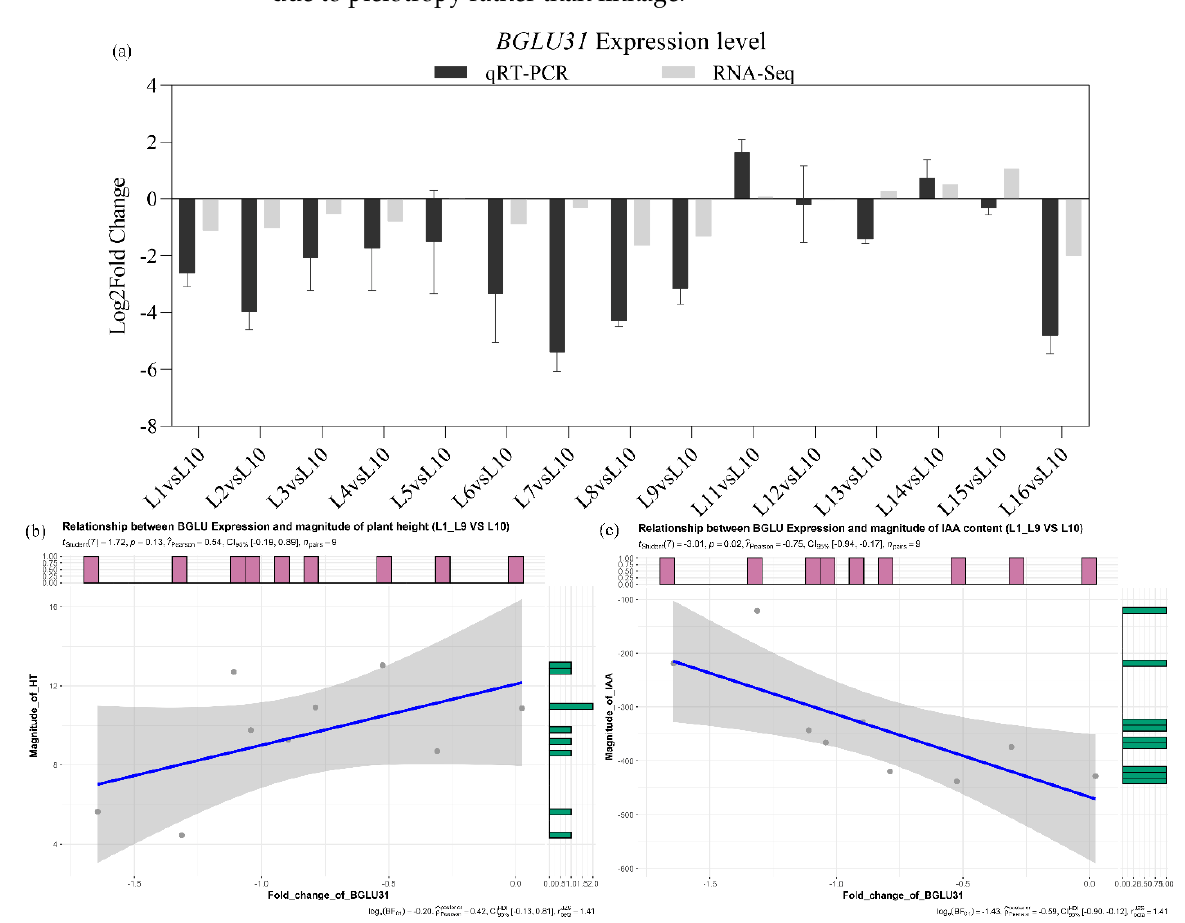
Figure 5. Gene expression and correlation coefficient analysis of CdBGLU31 . ( a ) Expression validation of CdBGLU31 between qRT-PCR and RNA-seq analysis. The L10 sample is the control reference, and the relative expression was determined by log2 FPKM and Log2 (fold change) compared to the control. All qRT-PCR reactions were performed from triplicate biological samples. The mean of three replicates ± standard error is shown. ( b ) Relationship between CdBGLU31 expression and magnitude of plant height (L1~L9 vs. L10). ( c ) Relationship between CdBGLU31 expression and magnitude of IAA content (L1~L9 vs. L10).